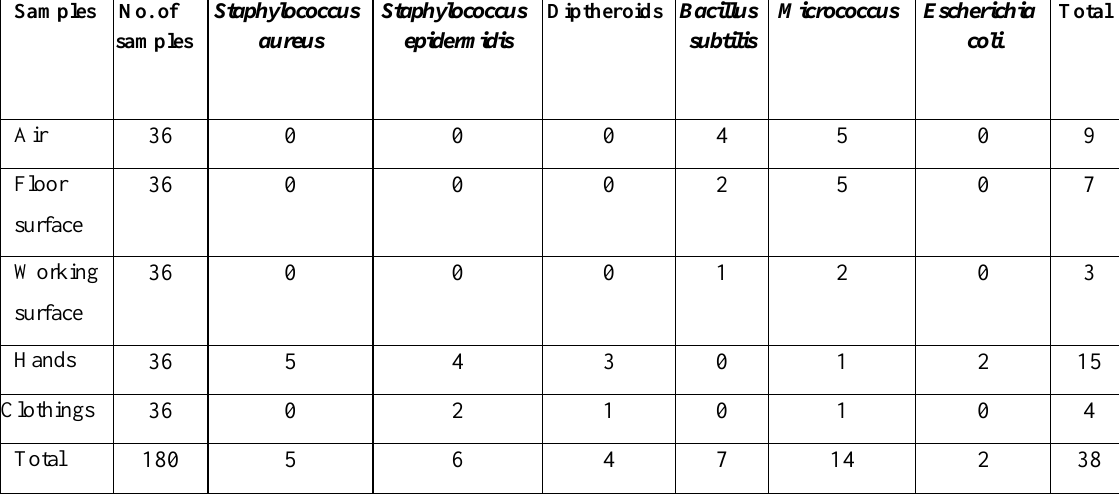
Table1. Number of bacterial isolates from various samples. Samples No.